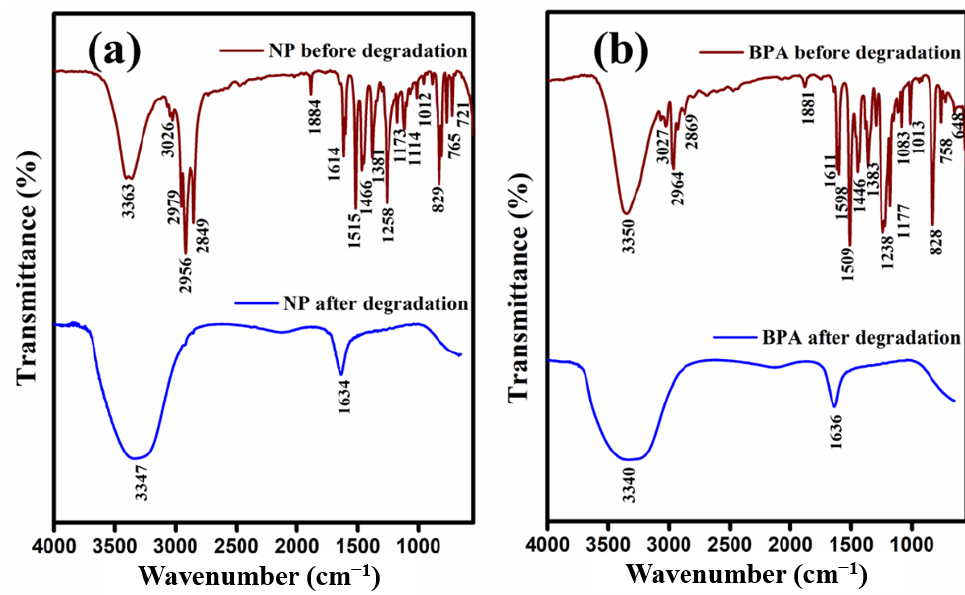
Figure 11. The FT-IR spectral proof for ( a ) NP and ( b ) BPA after decomposition over the surface of the CLMO catalyst.